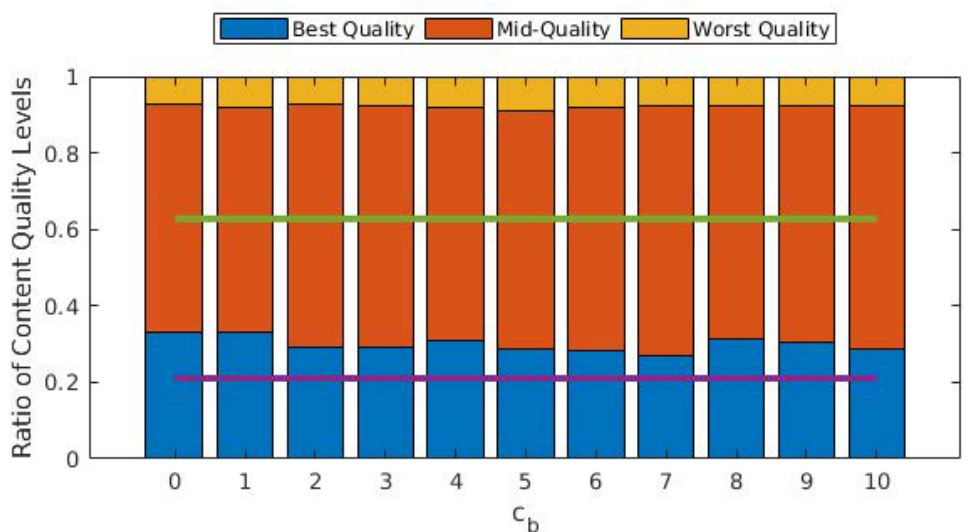
Figure 5. Ratios of the GOPs with respect to quality for different values of c b . Purple and green lines show the best and (cumulative) mid-quality ratios when D2D mode is disallowed.